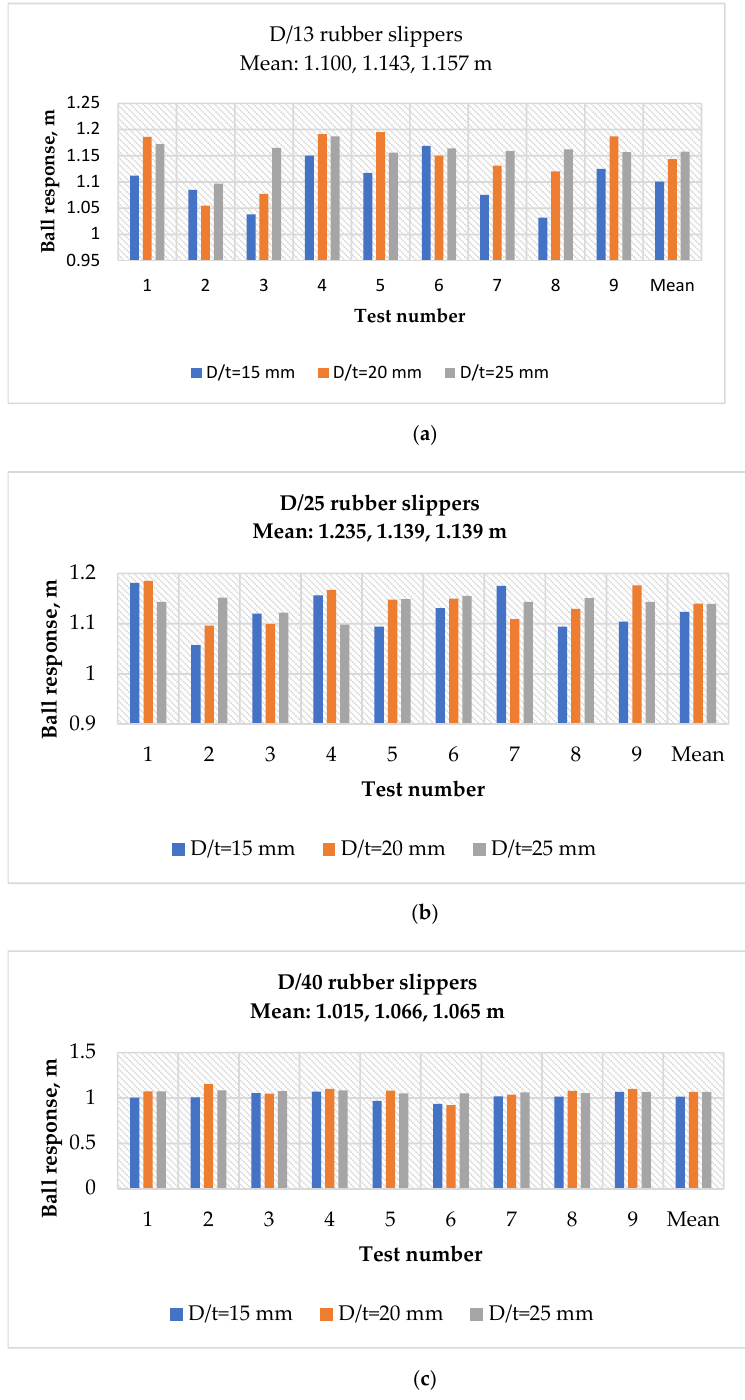
Figure 12. Ball response for D-type structure: ( a ) for structure with 13 rubber slippers; ( b ) for structure with 25 rubber slippers; ( c ) for structure with 40 rubber slippers.